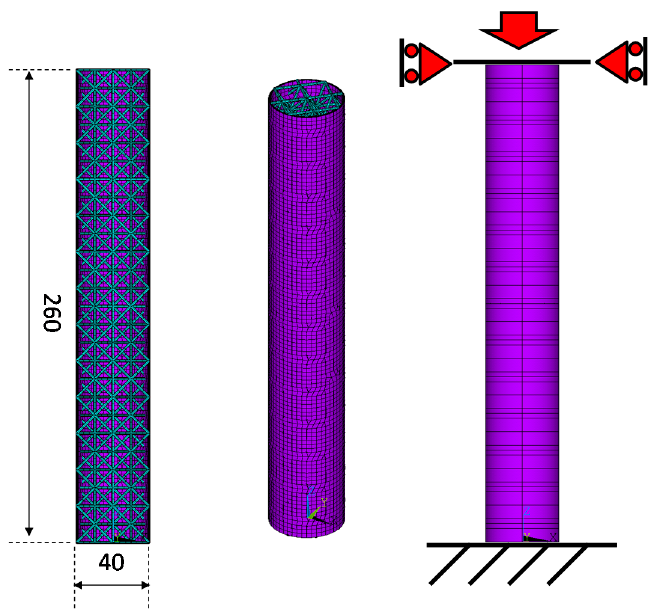
Figure 19. Test case 2—Geometry and boundary conditions.